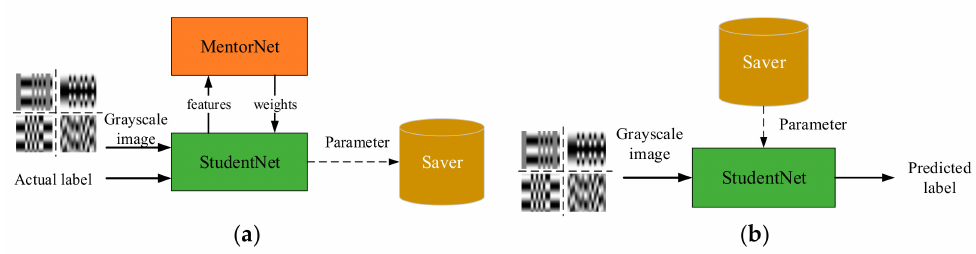
Figure 6. The diagrams of ( a ) training StudentNet under the supervision of MentorNet training and ( b ) testing the performance.